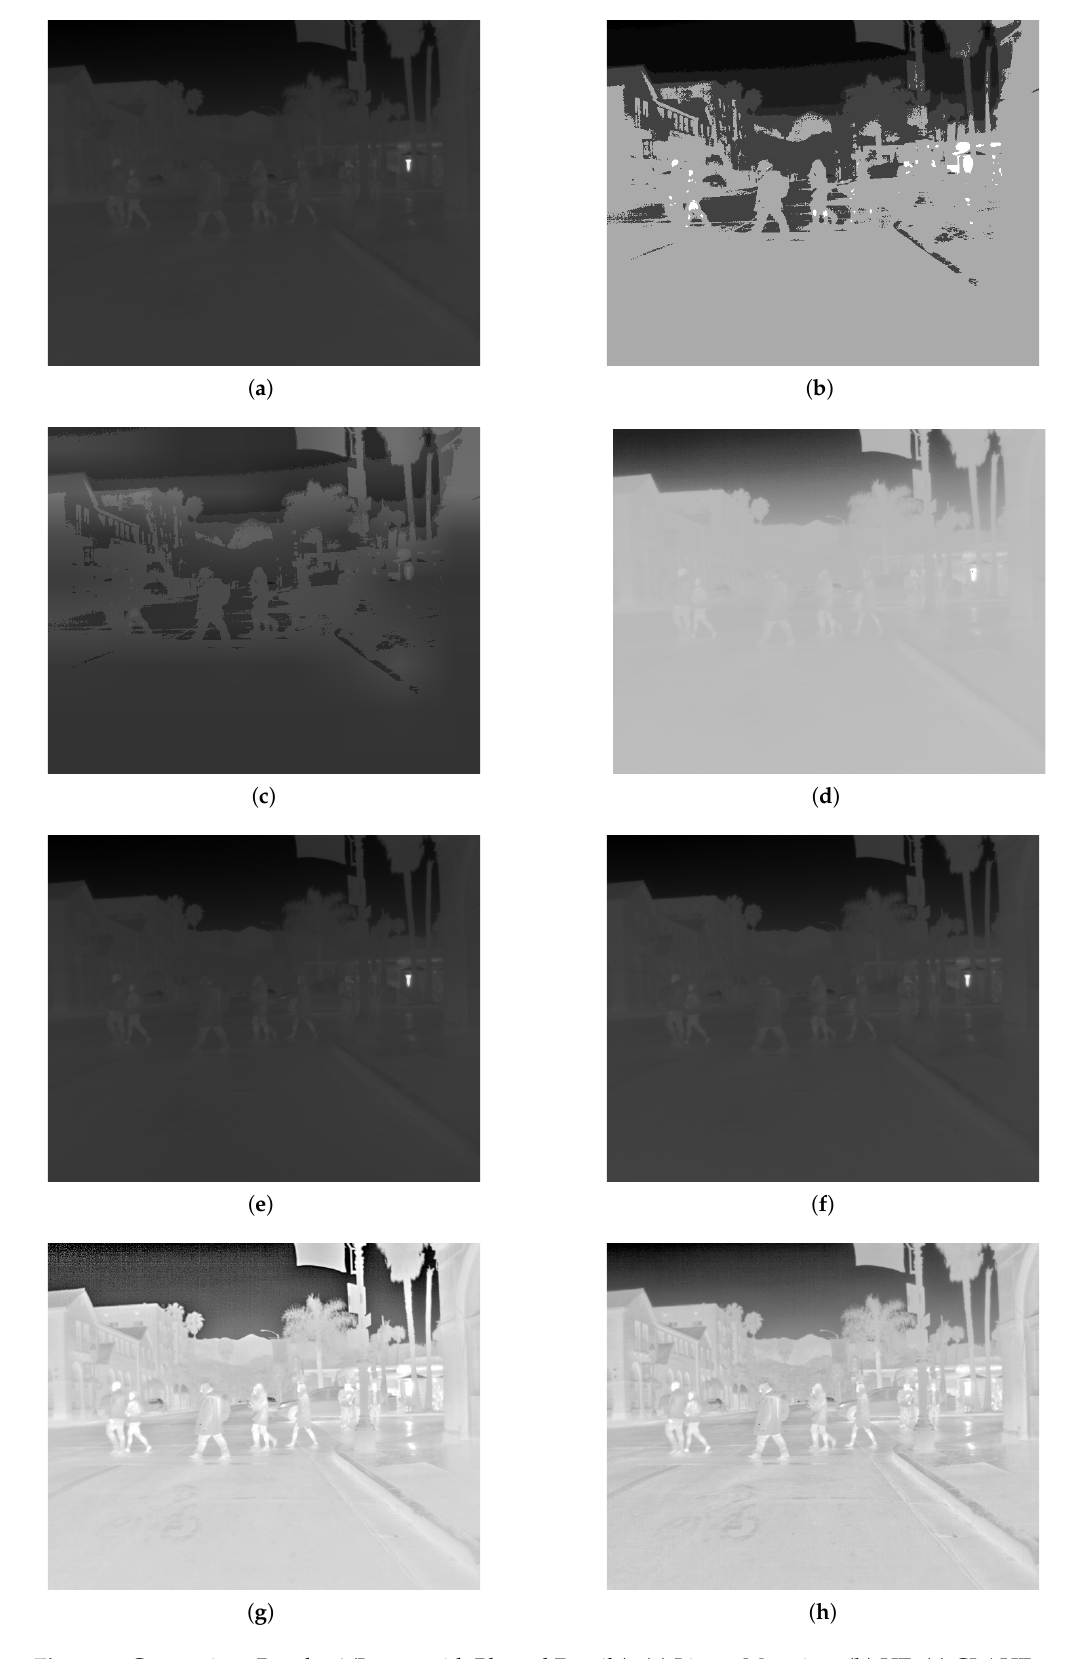
Figure 9. Comparison Results 6 (Image with Blurred Details). ( a ) Linear Mapping. ( b ) HE. ( c ) CLAHE. ( d ) AHPBC. ( e ) MSR. ( f ) Reinhard. ( g ) LEP. ( h ) Proposed